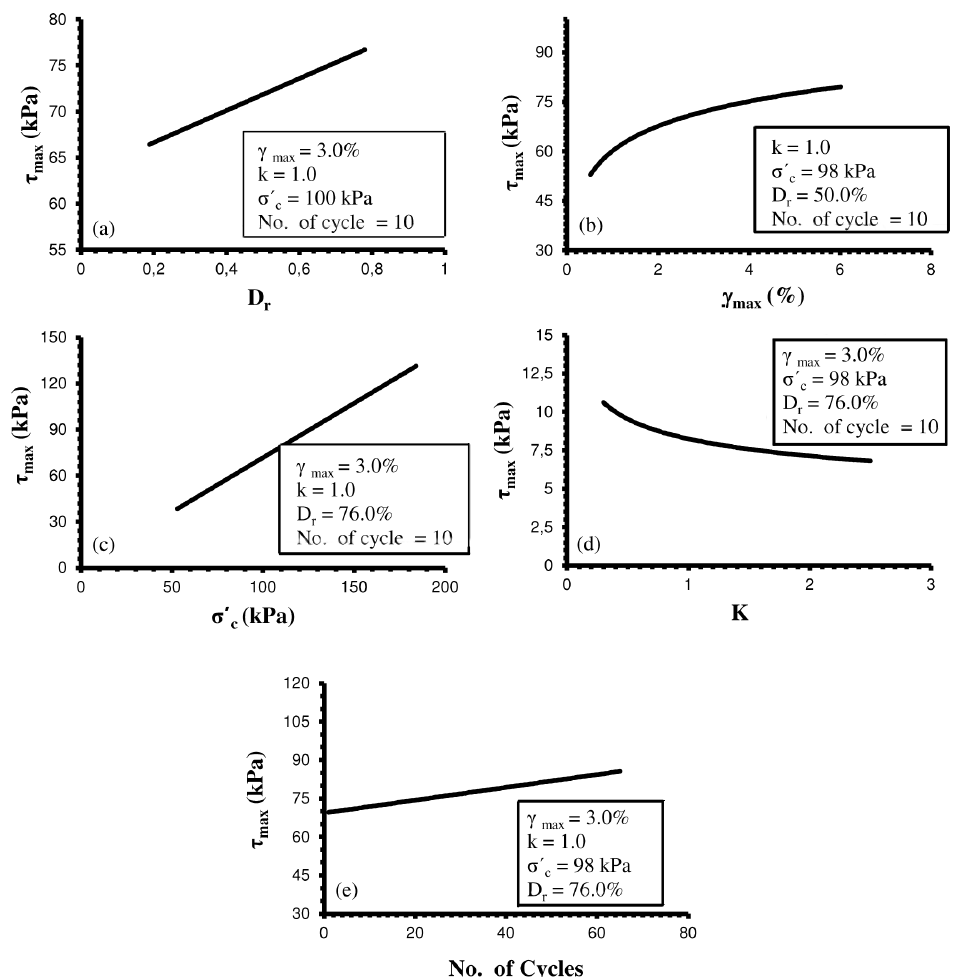
Fig. 11. Parametric analysis of the maximum shear